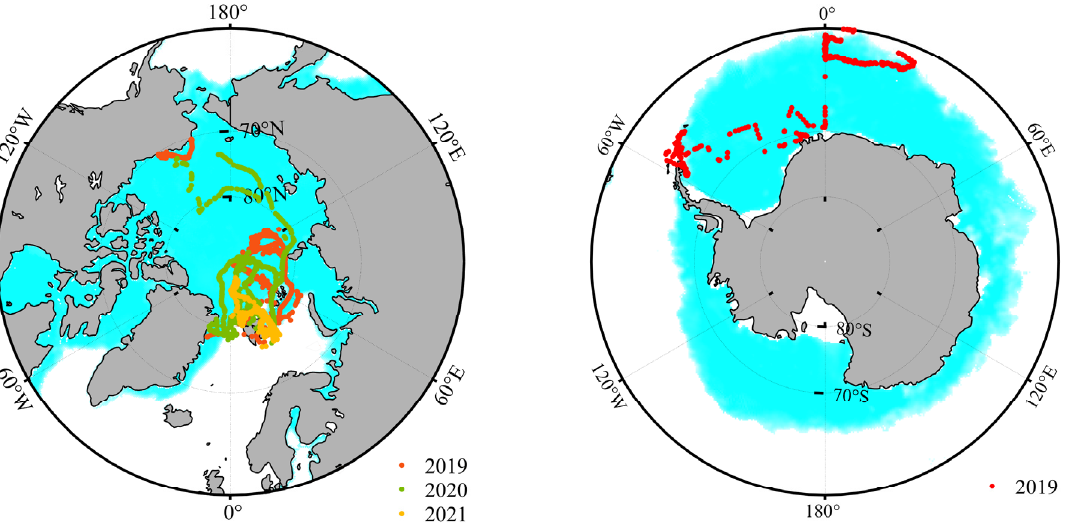
Figure 1. Spatial distribution of ship-based observation data, with red denoting 2019, green denoting 2020, and yellow denoting 2021. The background image is the SIE map on 5 February 2019 (( left ), Arctic; ( right ), Antarctic).